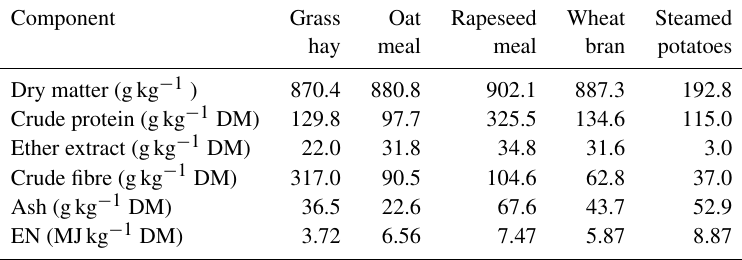
Table 1. The chemical composition and nutritional value of feeds used in lambs fattening. Component Grass Oat Rapeseed Wheat Steamed hay meal meal bran potatoes Dry matter (gkg − 1 )